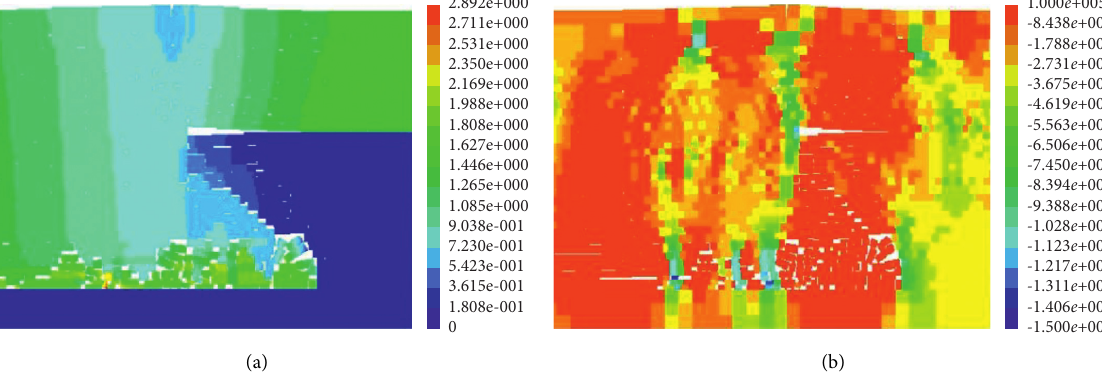
Figure 11: Evolution of displacement and stress in coal seam mining for the case where excavation of the lower coal seam was pushed over the boundary coal pillar by 10 m. (a) Nephogram of stope displacement. (b) Vertical stress cloud map of